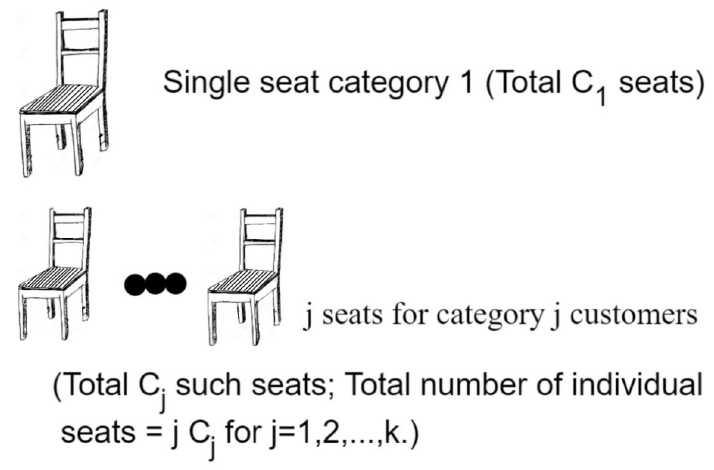
Figure 1. The total number of individual seats in a specific service room. The terms of transitions of the states are given in Tables 1–5. Table 1. Arrival rates for a new